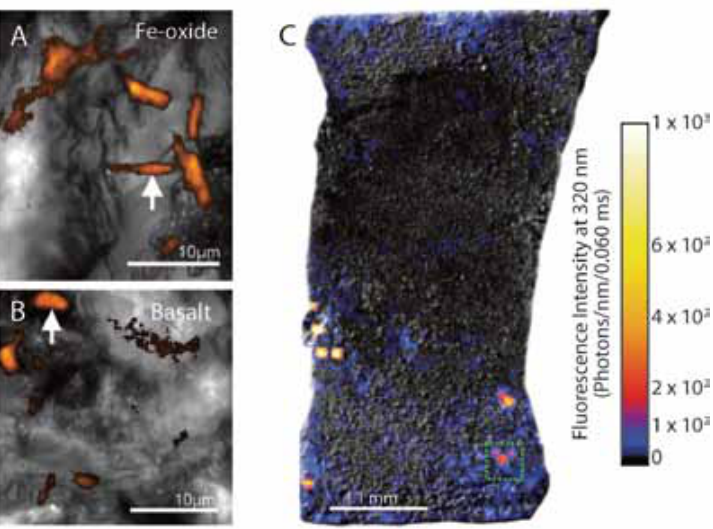
figure 3.4. a new technology for life detection using a deep-Uv laser induced by native fluorescence. microbial cells are visible as orange regions in deep-Uv native fluorescent images of (a) iron oxide, (B) basalt, and (c) a basalt chip from lo’ihi seamount. The photo is overlaying an image of visible and native deep-Uv fluorescence. note the change in scale from panels a and B to panel c. figures modified from Bhartia et al.